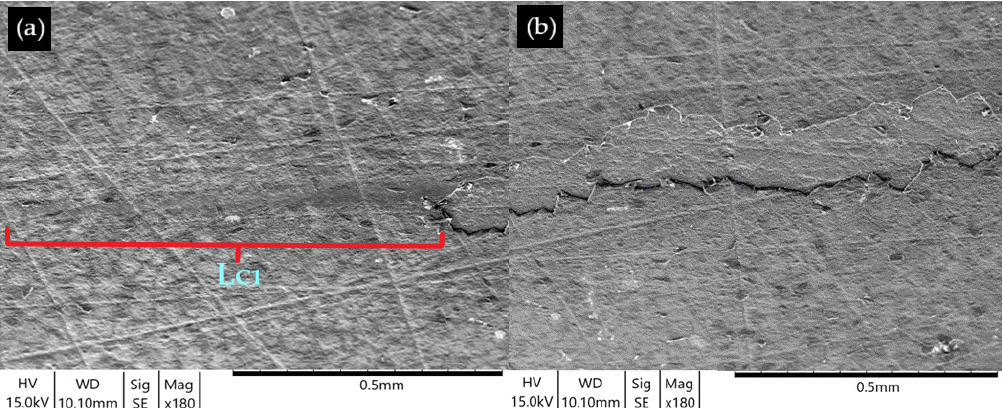
Figure 16. ( a ) Coating A scratch position 1 (initial scratch Lc1) and ( b ) Coating A scratch position 2 coating fractures and delamination positions at ×180 magnification. 2 coating fractures and delamination positions at × 180 magnification.